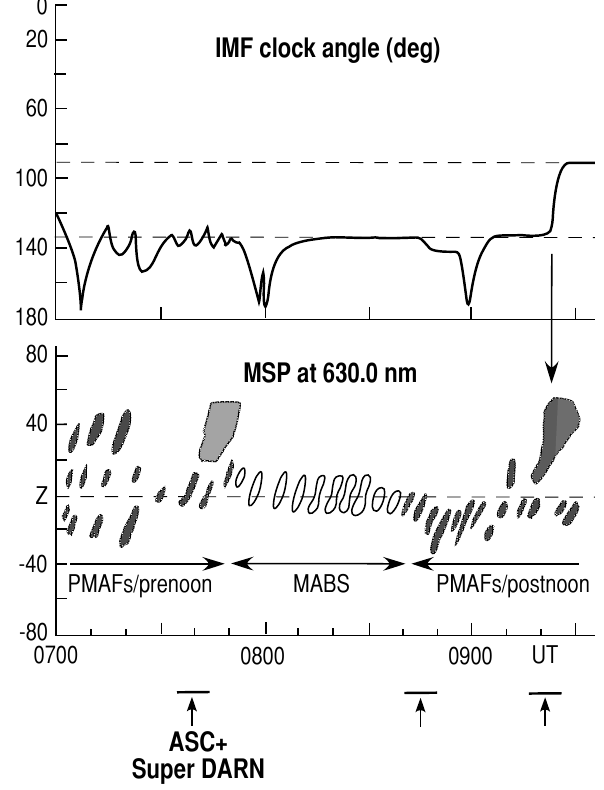
Fig. 4. Upper panel shows the IMF clock angle (Wind time plus 1h). Lower panel shows a schematic summary of the Ny ˚Alesund MSP data for the interval 0700-0930 UT representing three MLT sectors: prenoon, noon, and